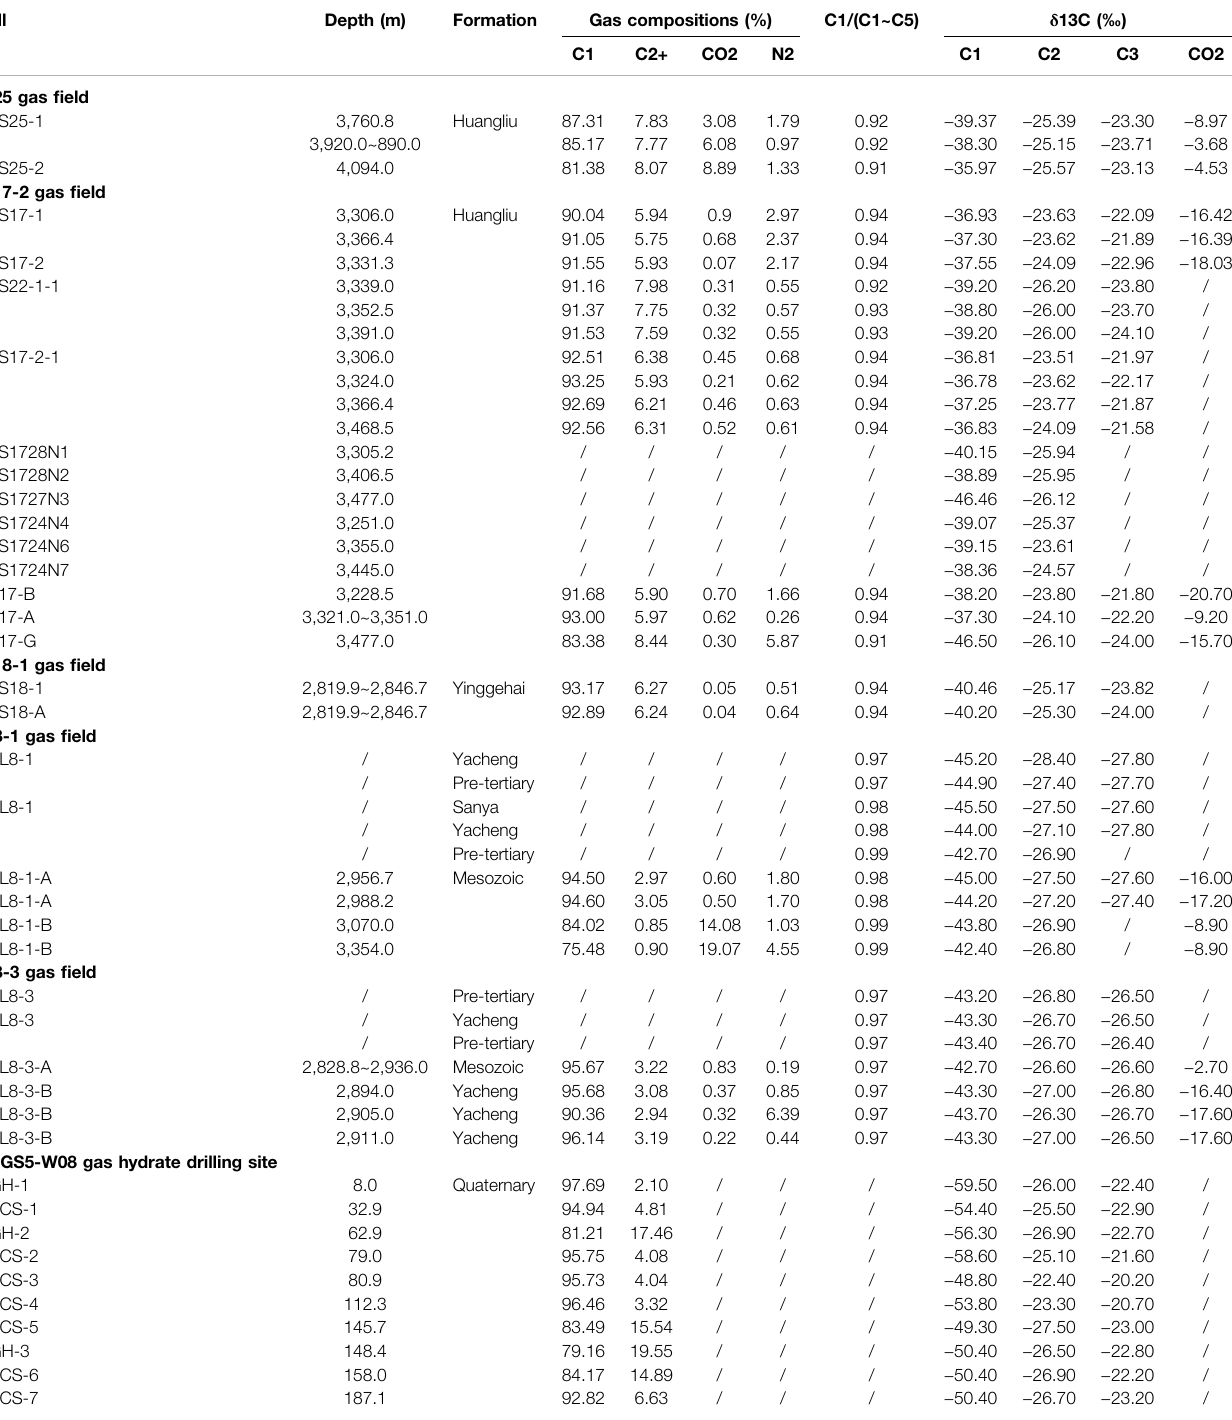
TABLE 2 | Gas composition and isotopic composition of the LS25, LS17-2, LS18-1, YL8-1, and YL8-3 large gas fi elds and hydrate-related gas at site GMGS-W08 in the QDNB. (Data were collected from Liang et al., 2015; Zhang et al., 2019a; Zhang et al., 2019b; Li et al., 2020; Lai et al., 2021; Yang et al., 2021; Zhu et al., 2021). Well Depth (m)